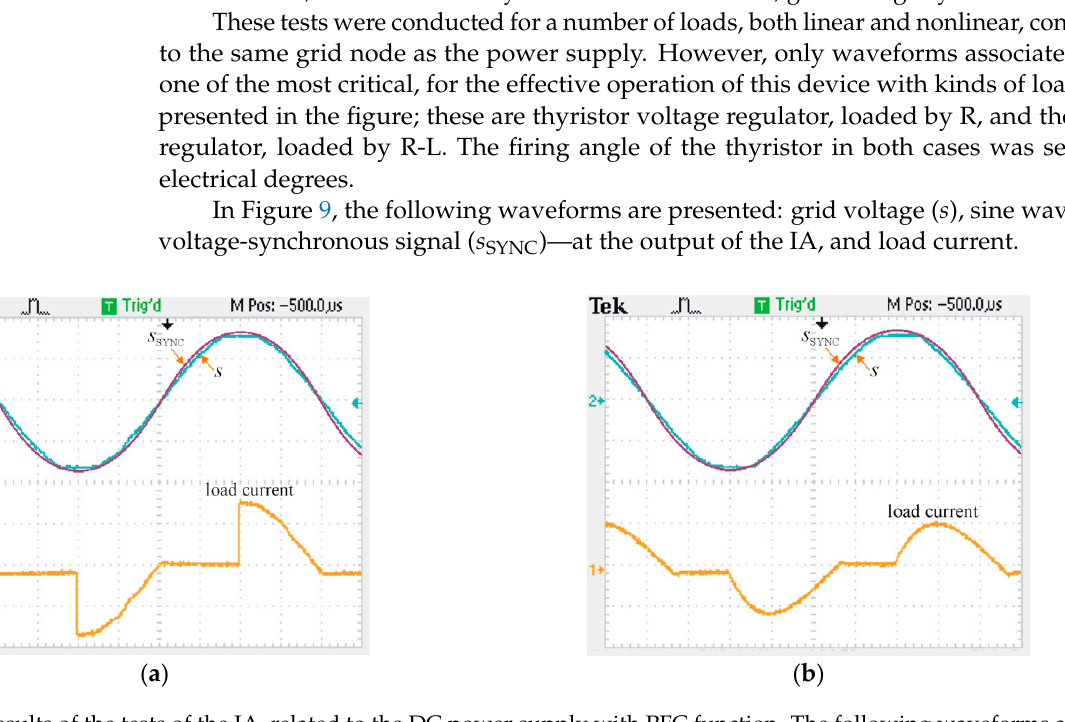
Figure 9. Results of the tests of the IA, related to the DC power supply with PFC function. The following waveforms are shown: grid voltage (blue), grid voltage synchronous signal (red), and load current (yellow)—for the two cases of load—the thyristor voltage regulator loaded by R ( a ) and R-L ( b ).